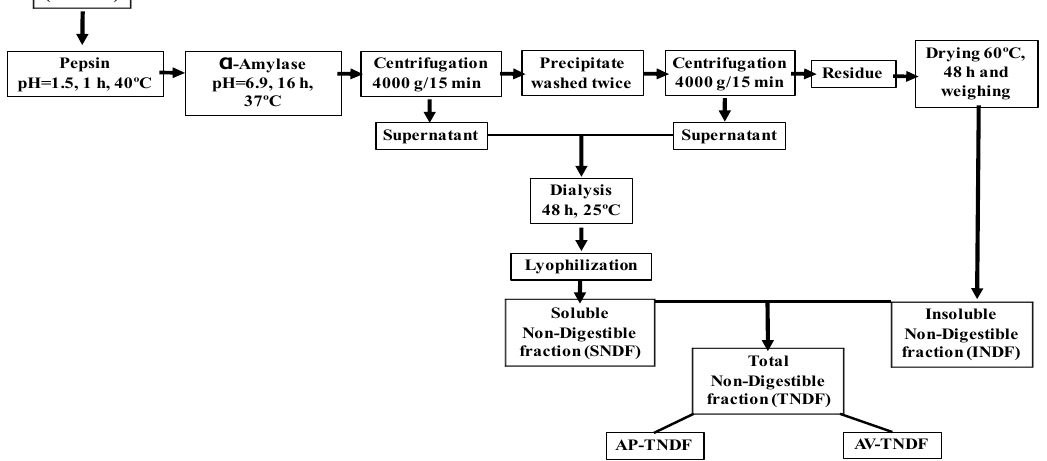
Figure 5. Indigestible fraction. The obtaining of indigestible fractions of AV and AP. AV = Aloe vera gel, AP = Aloe polysaccharides; AV-NDF = Insoluble non-digestible fraction of AV, AP-NDF = Insoluble non digestible fraction of AP, AV-SNDF = Soluble fraction of the non-digestible fibre of AV, AP-SNDF = Soluble fraction of non-digestible fibre of AP .